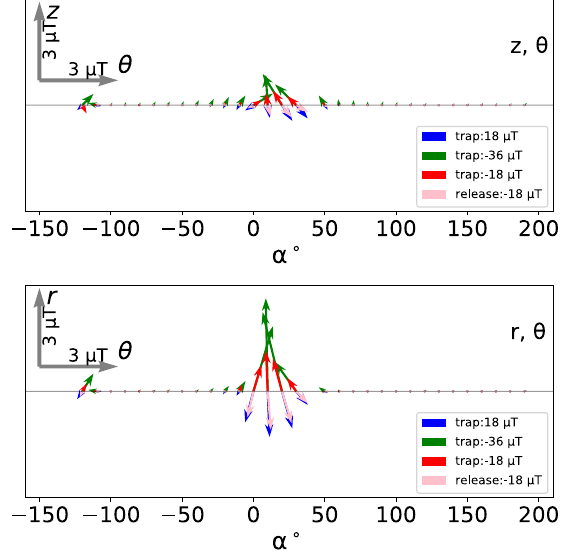
FIG. 12. Comparison of the difference in the magnetic fields before and after quenching with different applied magnetic fields. The top plot shows the z and θ relationship of the change in magnetic fields. The bottom plot shows the r and θ relationship of the change in magnetic field.